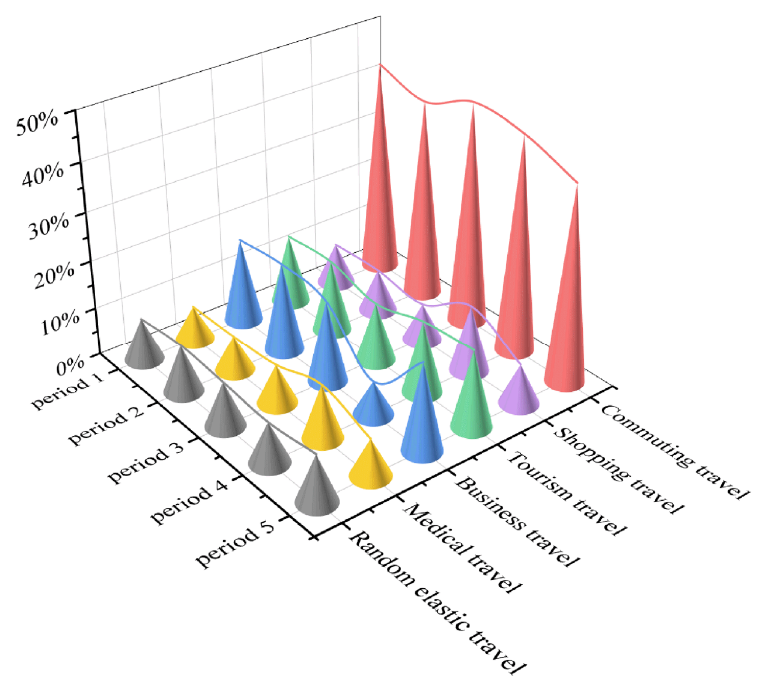
Figure 12. The ratios of residential travel with different purposes over different periods. Period 1 represents the normal period of society. Period 2 represents the early period of COVID-19. Period 3 represents the outbreak period of COVID-19. Period 4 represents the rework period of society. Period 5 represents the recovery period of society.